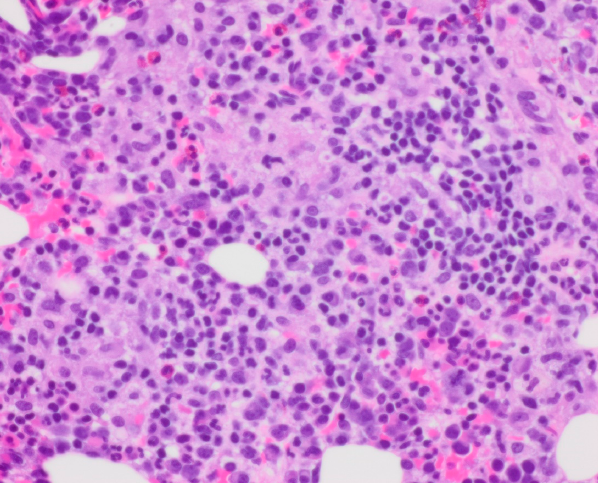
Figure 1. Clot section, macrophages. Hemotoxylin and Eosin (H and E) staining with 40× objective magnification.